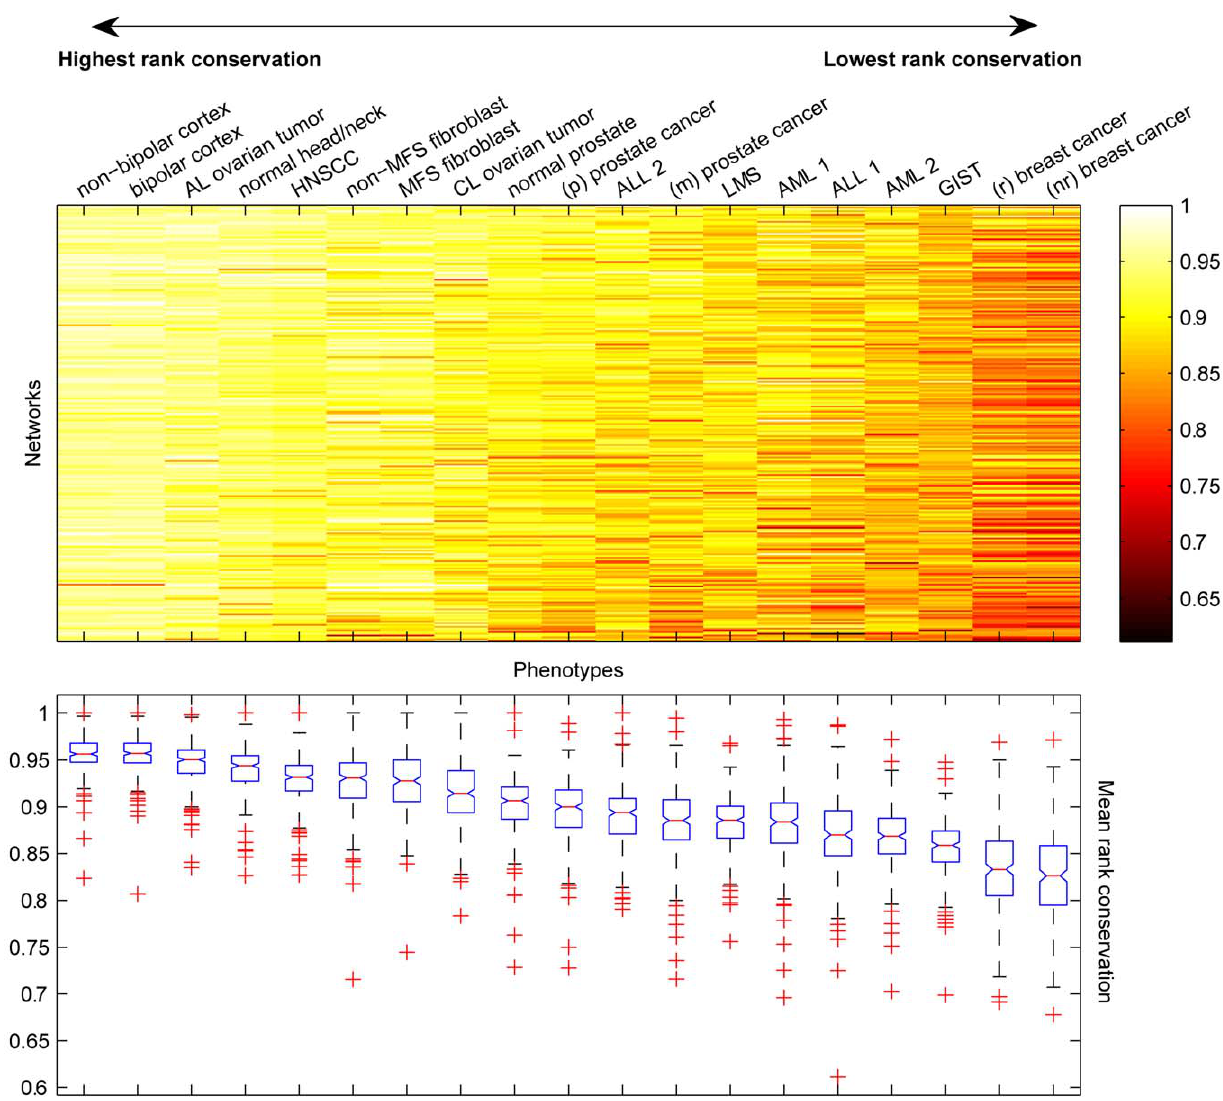
Figure 5. Diverse rank conservation of networks across phenotypes. Colors on the heatmap represent rank conservation indices for each network in 19 different phenotypes, where brightest indicates very tight regulation of network ranking in a phenotype and darkest indicates loose regulation of networks, with greater shuffling of gene rankings.